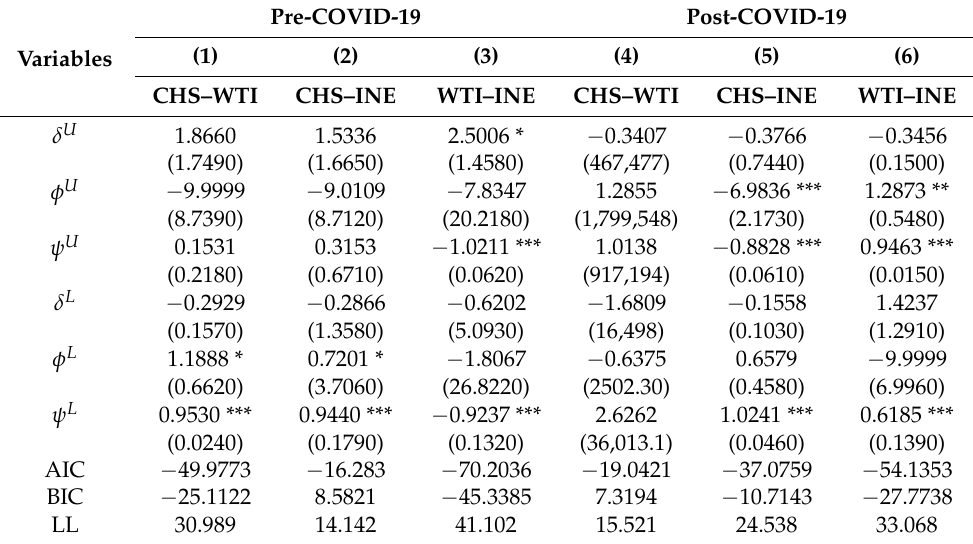
Table 6. Estimation results of the time-varying SJC-Copula model for paired markets (pre-and post-COVID-19